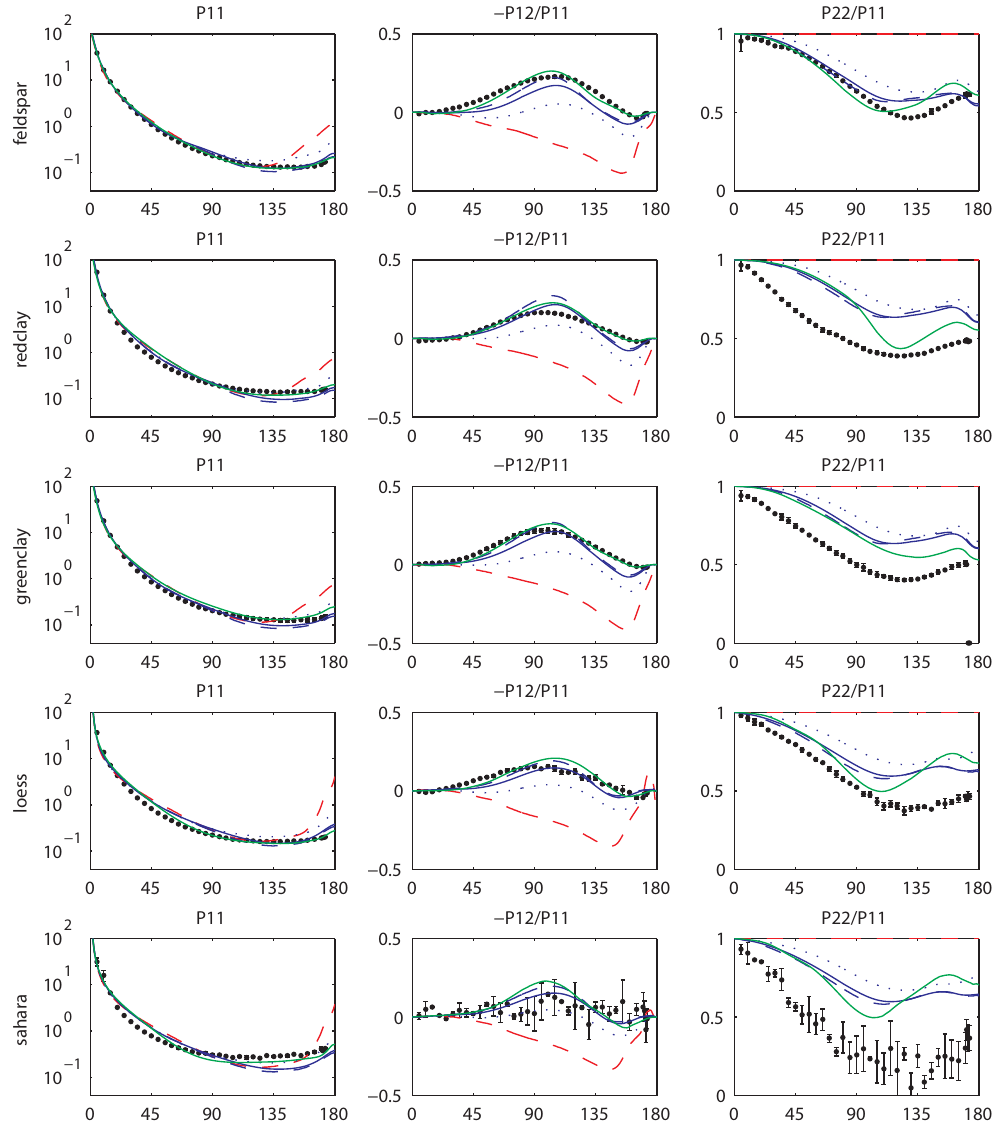
Fig. 7. Measurements with error bars (black), spheroid models (blue and green), and HSA (red) shown for the three key scattering-matrix elements of every sample. Three ξ n model runs, n = 0 (dotted blue line), 3 (solid blue line), and 10 (dashed blue line) are shown as well as the optimal shape distribution (solid green line). Here we have used λ = 632 .